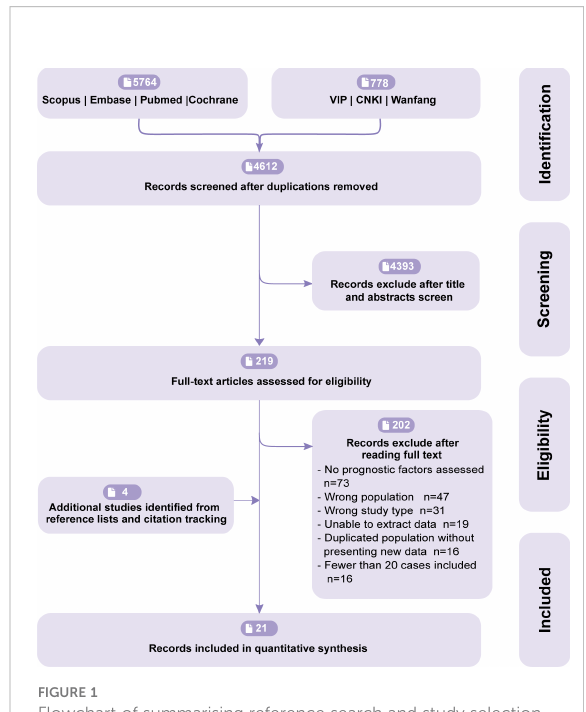
FIGURE 1 Flowchart of summarising reference search and study